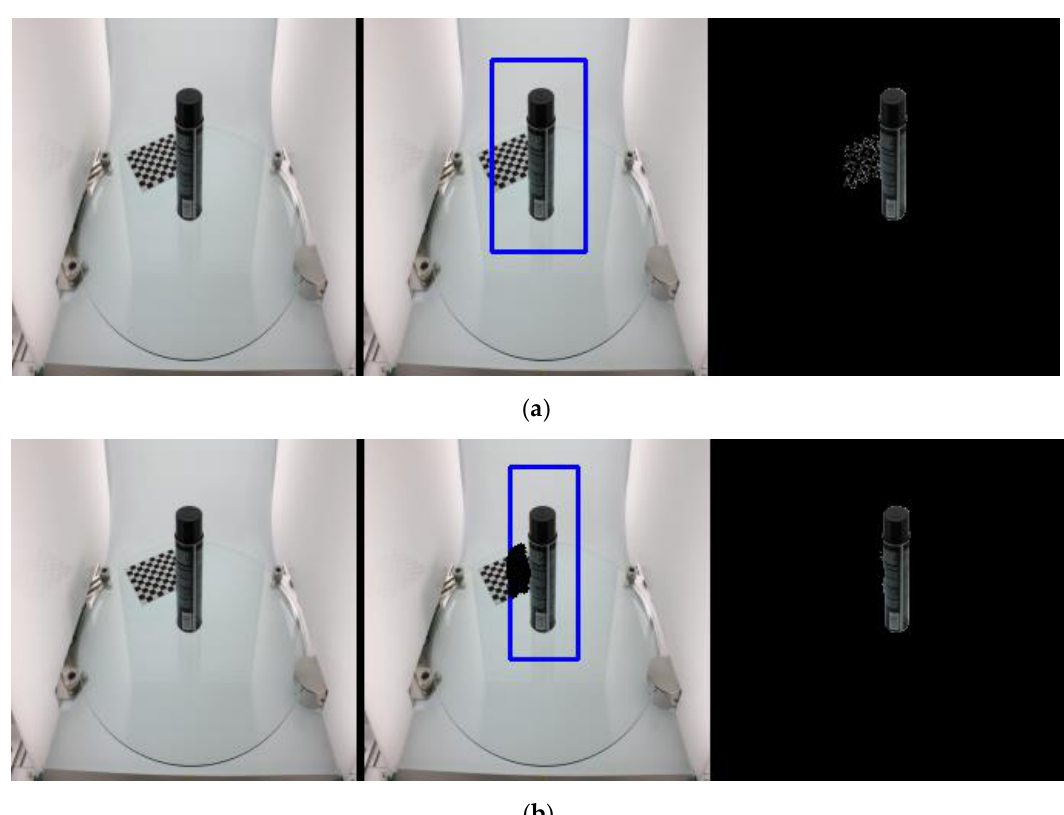
Figure 16. ( a ) Segmentation results with directly selected target area; ( b ) segmentation results with additional marking operation.